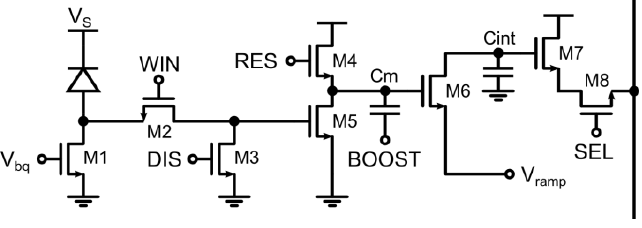
Figure 9. Compact NMOS-only TAC-based pixel [38].